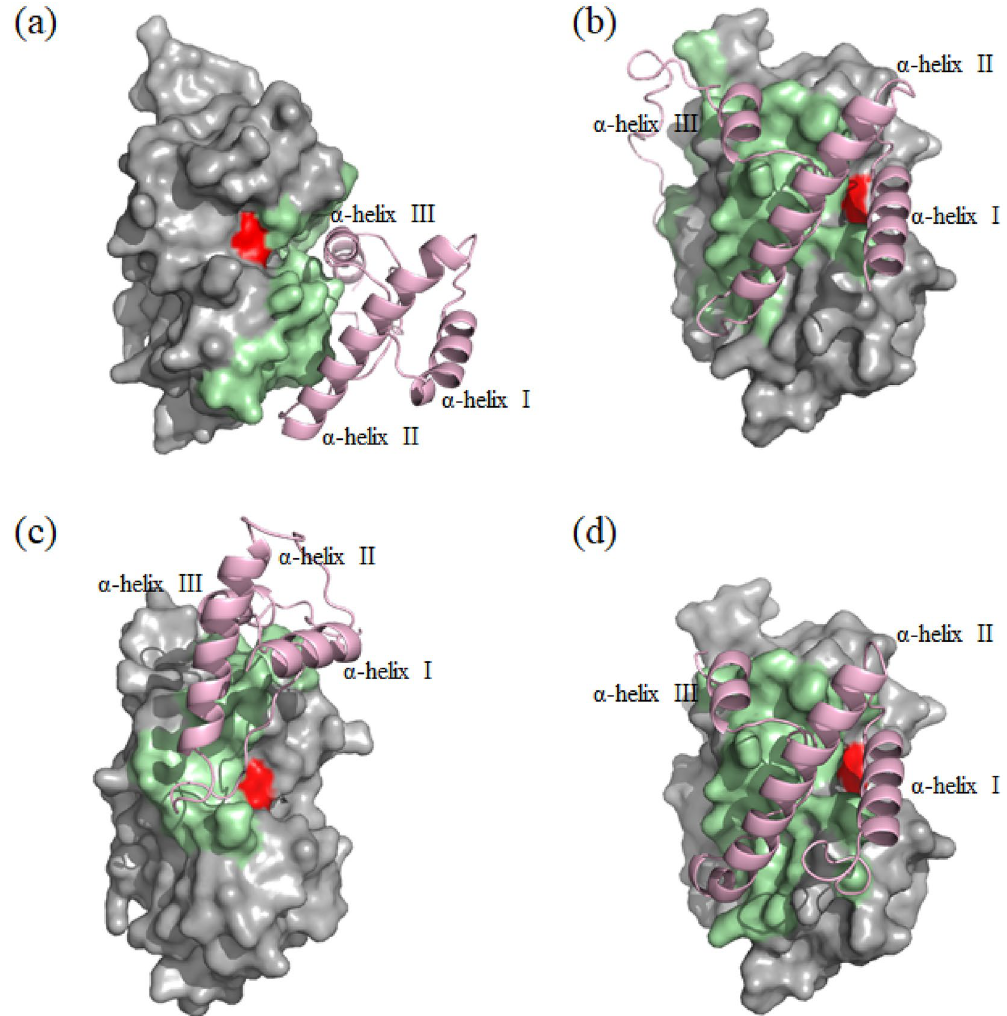
Figure 7. Protein–protein docking simulation of cathepsin L and SnuCalCpIs. ( a ) cathepsin L-SnuCalCpI02 complex, ( b ) cathepsin L-SnuCalCpI03 complex, ( c ) cathepsin L-SnuCalCpI12 complex, and ( d ) cathepsin L-SnuCalCpI15 complex. The enzyme and inhibitor were represented in gray and lightpink, respectively. The catalytic dyad (Cys25 and His163) and interface residues were illustrated in red and palegreen, respectively. The protein–protein complex was visualized using Pymol software (version 2.5.2).